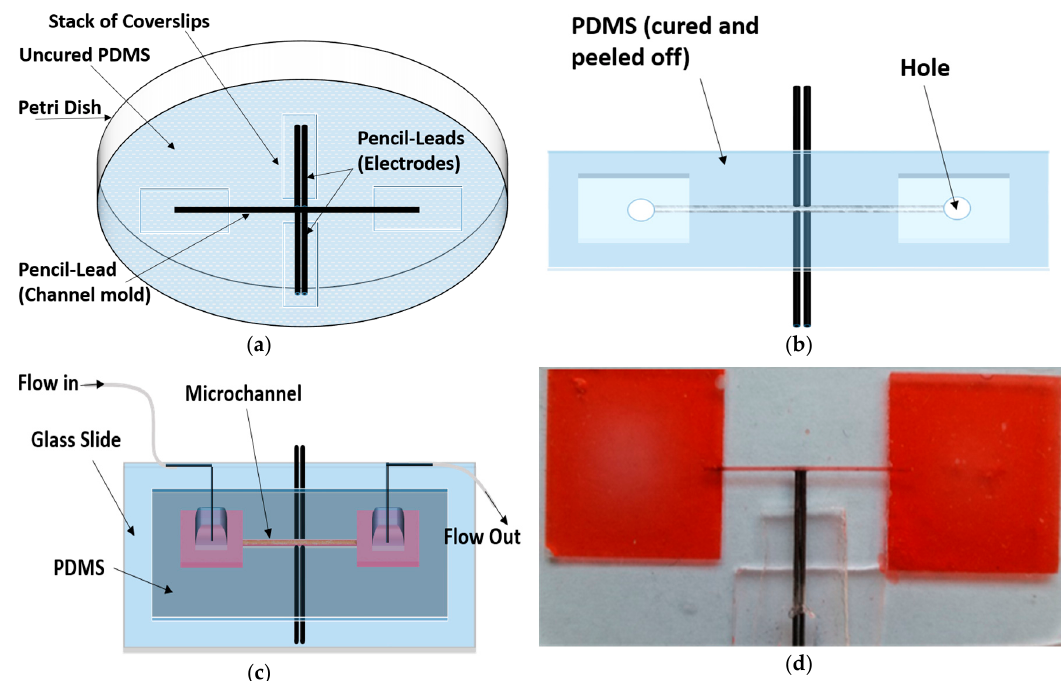
Figure 1 . Device fabrication. ( a ) Pencil-leads were positioned on stacks of coverslips sitting on the Petri dish and the polydimethylsiloxane (PDMS ) was cast and cured; ( b ) PDMS including the embedded pencil-leads and coverslips was gently peeled off and the coverslip stacks were removed. The unmolded PDMS was placed on the workbench with the side containing the reservoirs face up, and the central lead (microchannel mold) was removed. The sides of the cured PDMS were cut and removed so that the electrodes could be connected to the power supply. Then, holes were punched into the reservoirs; ( c ) the PDMS containing the microchannel was cleaned, treated and bonded to a treated clean glass slide. Finally, the inlet and outlet tubes were connected to the reservoirs (optionally, the tubes were connected to the reservoirs through small pieces of PDMS bonded to the parts of the device containing the holes in order for inlet and outlet tubes to be fixed tightly in their positions); ( d ) functionality of the microchannel was tested before connecting the